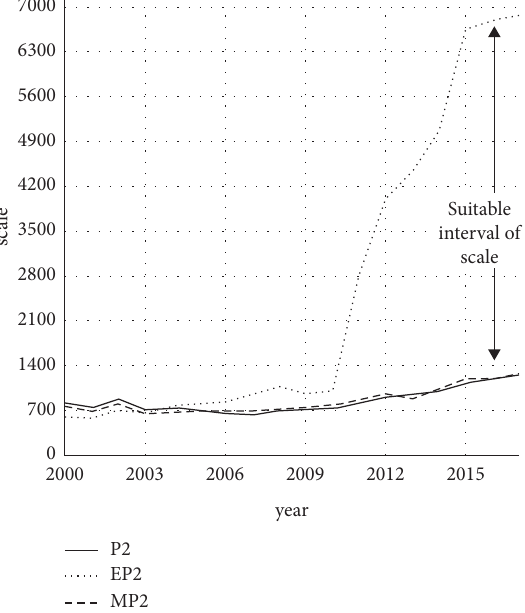
Figure 3: Trend comparison of P